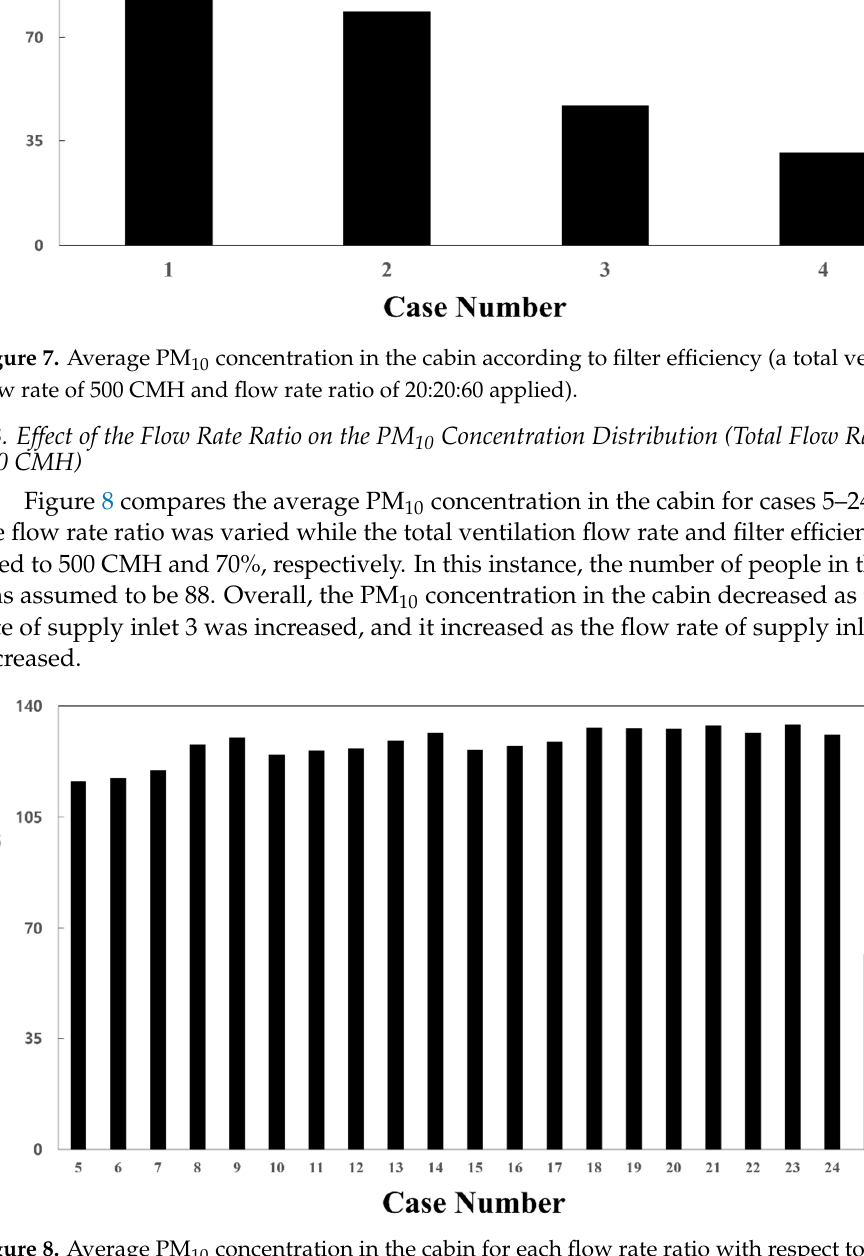
Figure 8. Average PM 10 concentration in the cabin for each flow rate ratio with respect to the total ventilation flow rate of 500 CMH (filter efficiency of 70% applied for cases 5–24, 80% for case 25, and 85% for case 26).